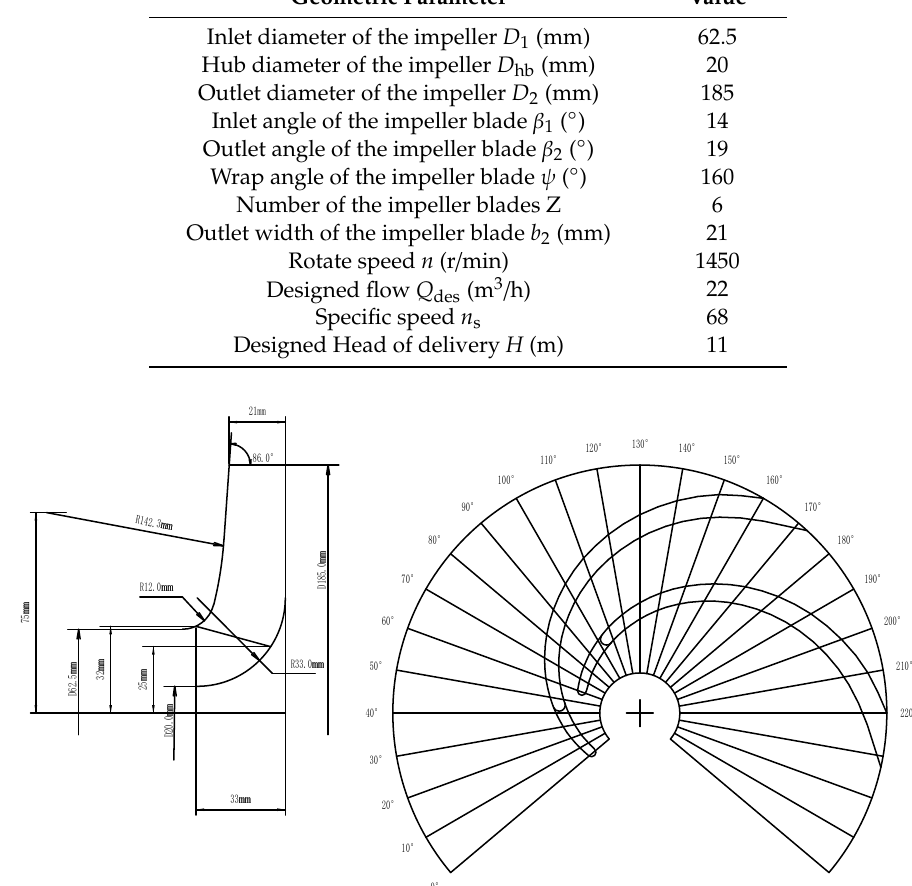
Figure 2. Hydraulic model of Impeller